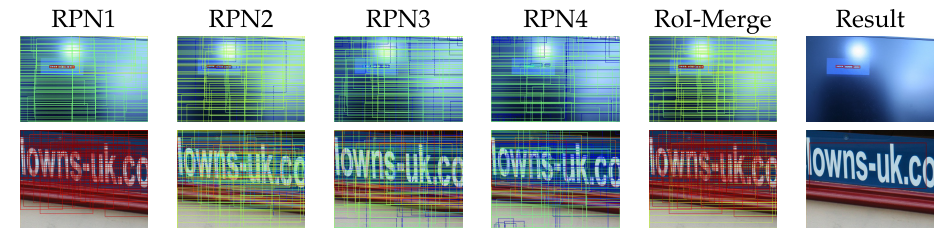
Figure 7. The outputs from each region proposal network (RPN). Red rectangles have high confidence, and blue rectangles have low confidence.